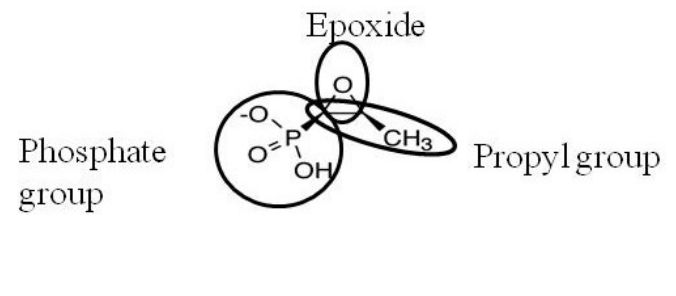
Figure 1. Chemical structure of fosfomycin [(2 R ,3 S -3-methyloxiran-2-yl) phosphonic